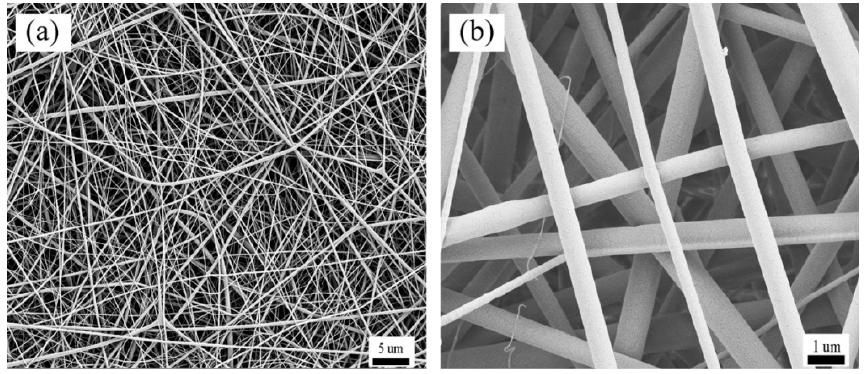
Figure 5. FE-SEM images of electrospun silk fibroin (SF)/polycaprolactone (PCL) nanofibrous mats.